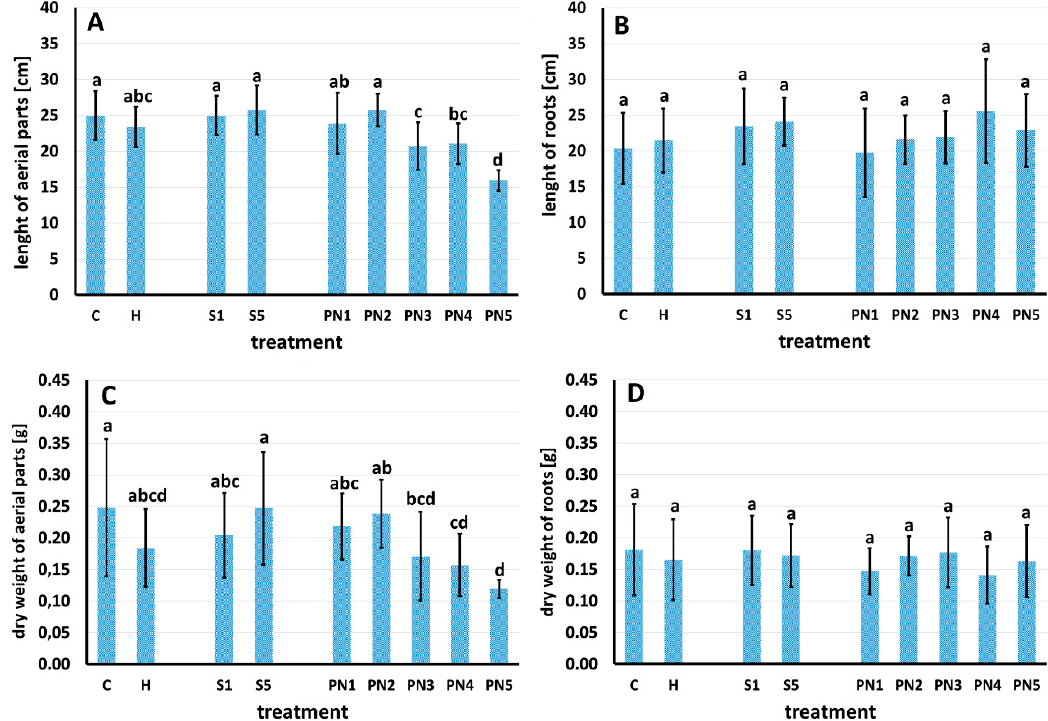
Seven days after spraying, significant changes in the length and dry weight of the aerial parts of maize (Figure 7A,B), and no effect on the length and dry weight of maize roots, were observed (Figure 7C,D).